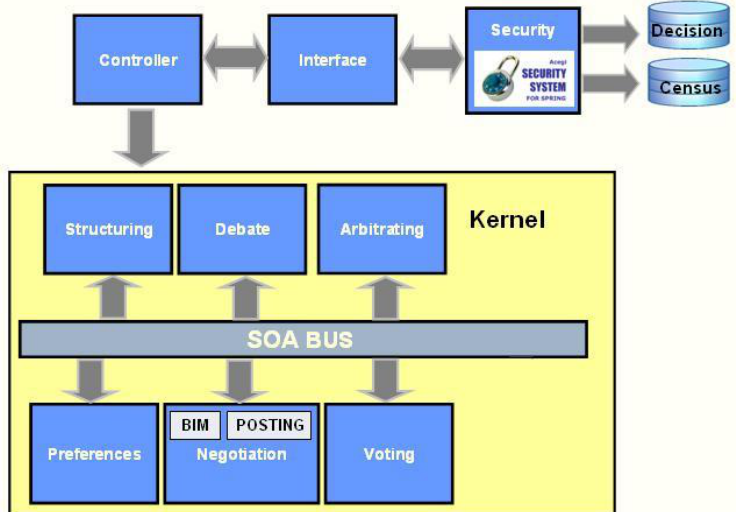
Figure 3: Architecture for participatory budgeting